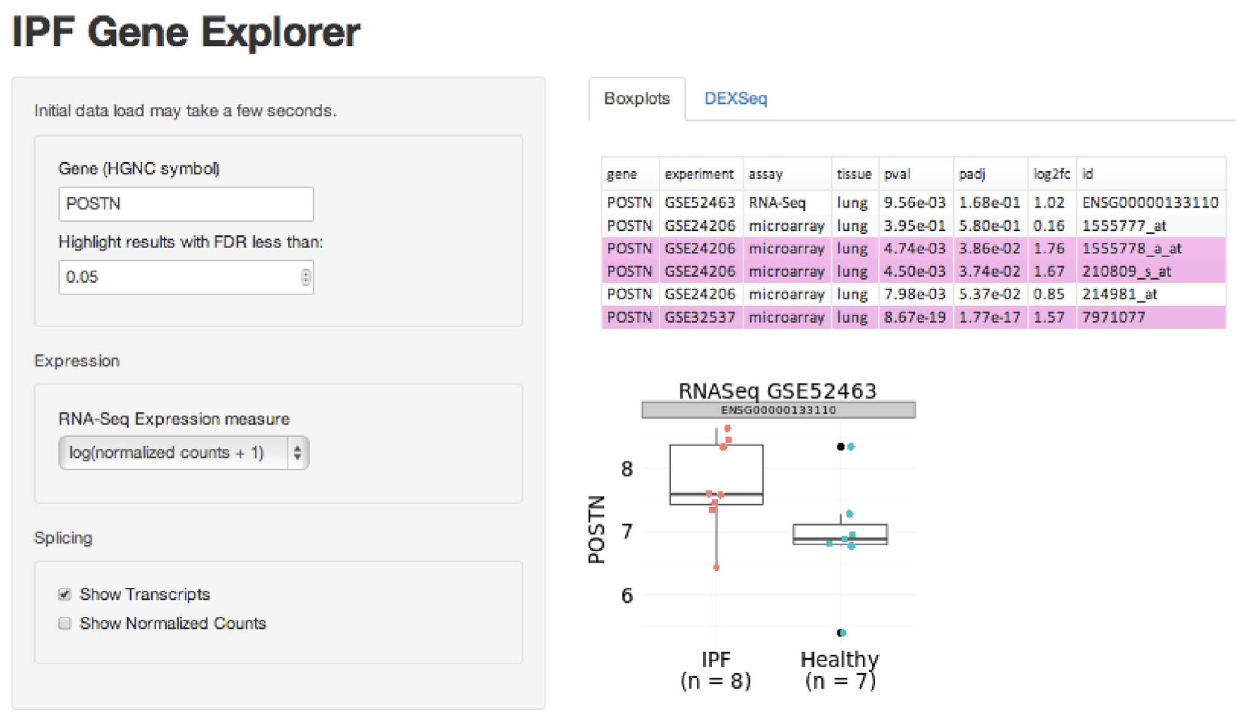
Figure 11. The IPF Gene Set Explorer displays expression data for a set of user-selected genes.